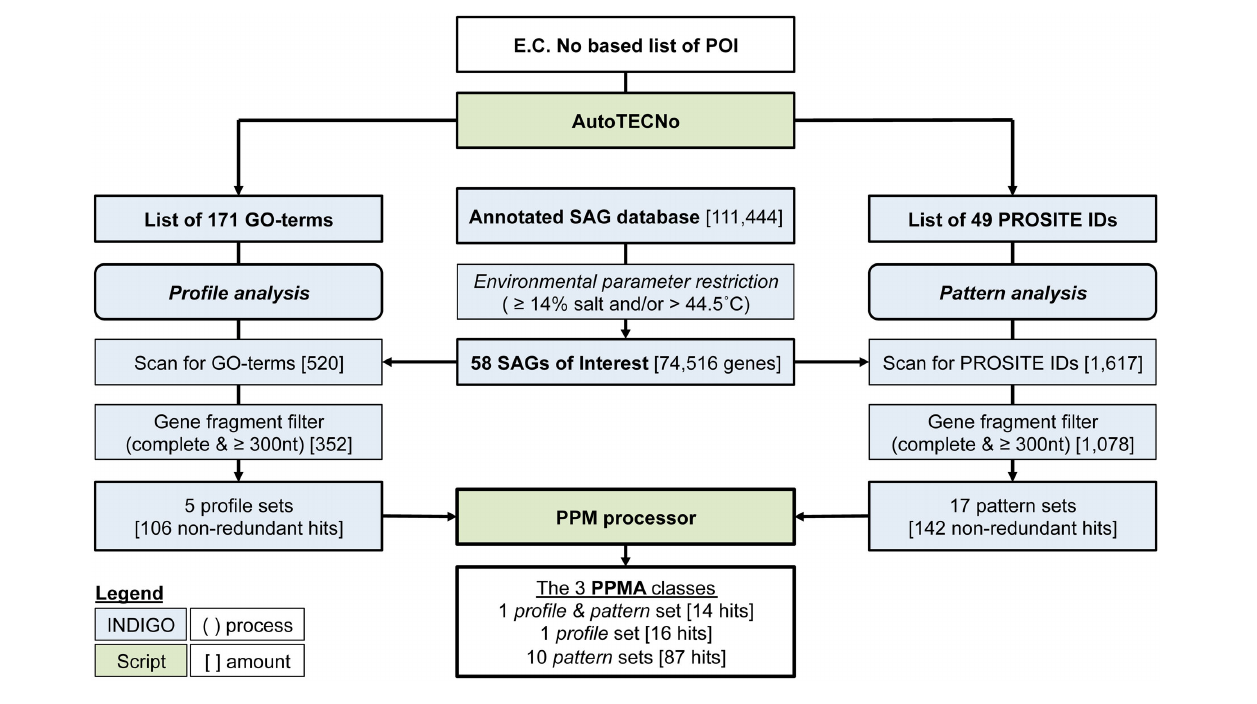
FIGURE 2 | Flowchart illustrating the PPM (profile pattern matching) algorithm, starting from an E.C. Number based proteins of interest (POI) list and a selected database subset, which may also be uploaded externally. Numbers refer to the example published here. Square brackets indicate